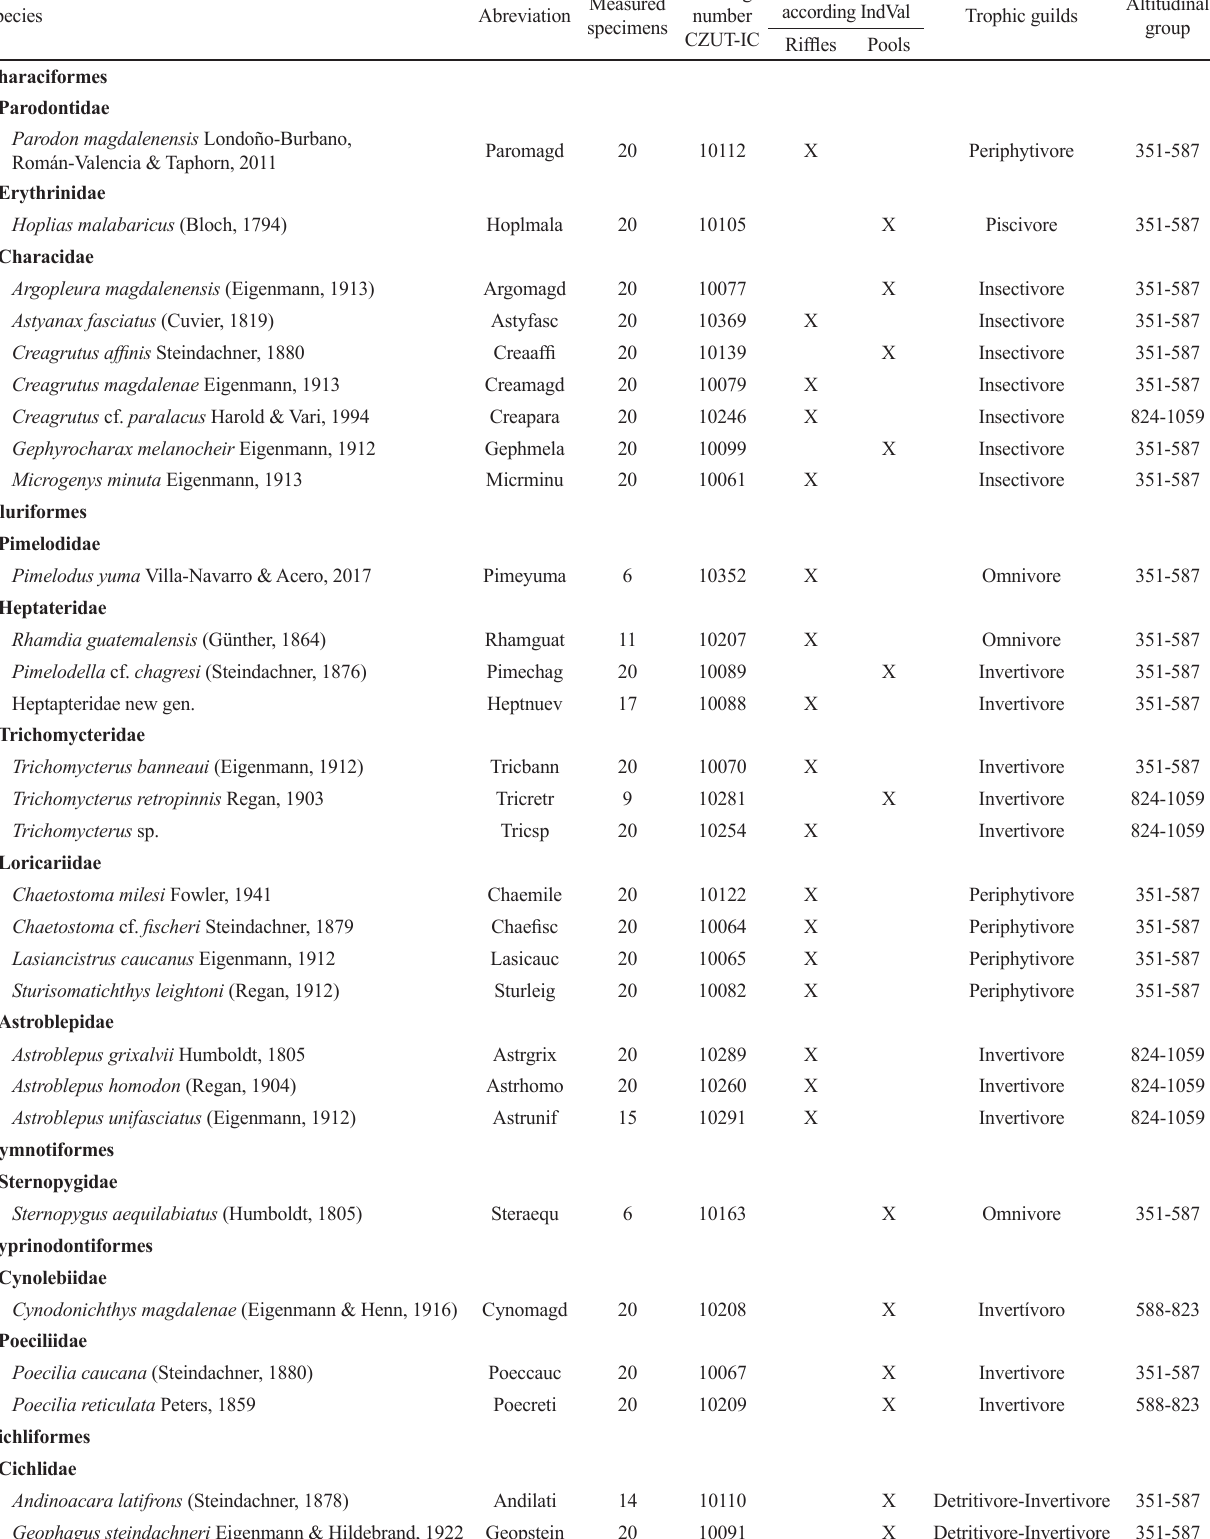
Tab. 3. Trans-Andean fish species of the Alvarado River drainage, Upper Magdalena River Basin, Colombia, with their catalog numbers in the ichthyological collection of the Universidad del Tolima, Colombia (CZUT-IC). Habitat association according to the species indicator value (IndVal), trophic guilds and altitudinal